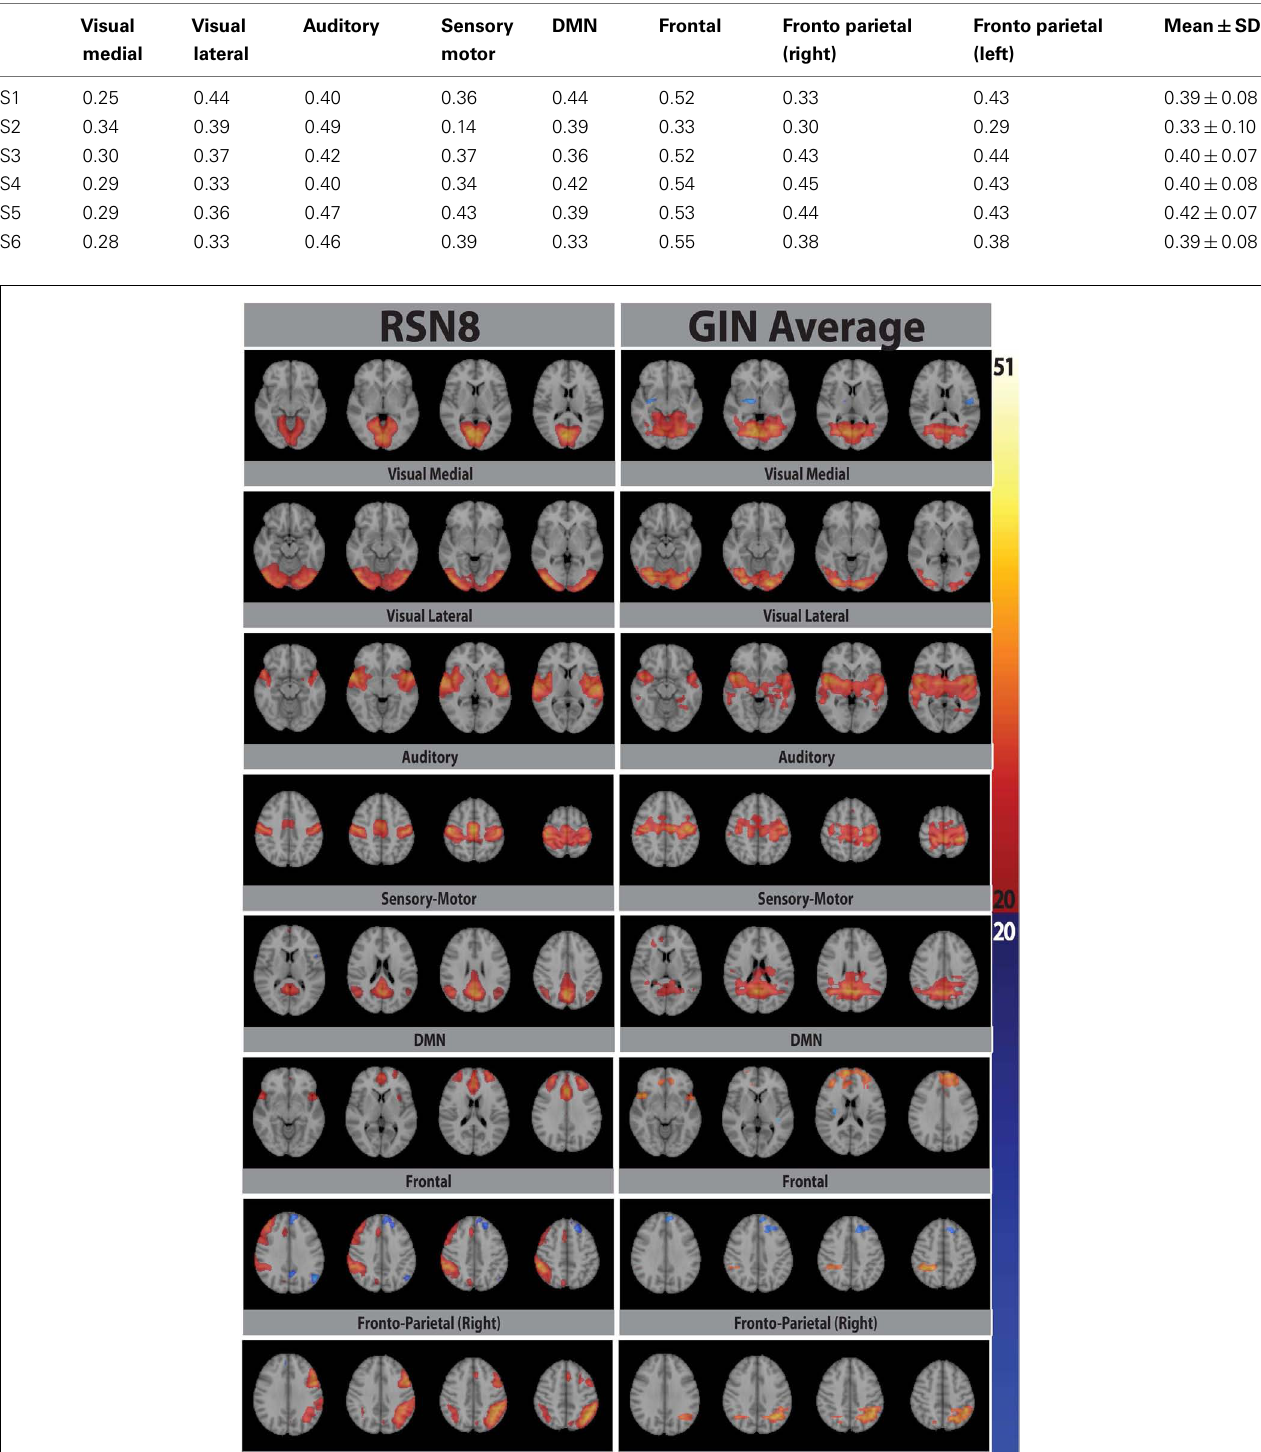
Table 1 | DICE overlap scores for all the subjects and RSNs.